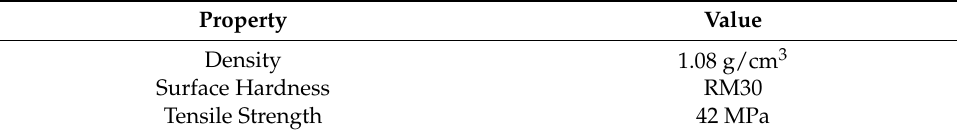
Table 2. Properties of HIPS